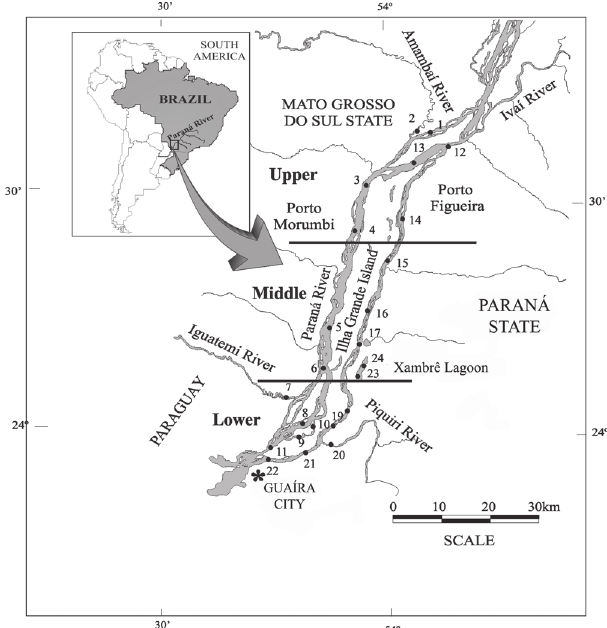
Fig. 1. Location of the sampling sites in the Ilha